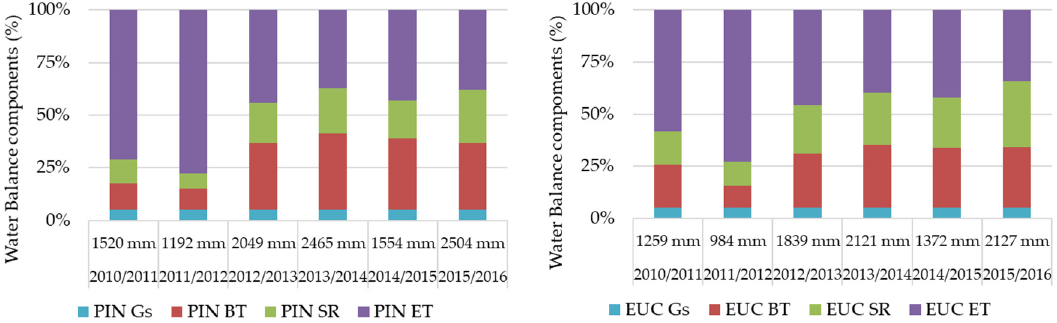
Figure 2. Components of the water balance in both Lourizela (PIN, left side ) and Serra de Cima (EUC, right side ) catchments, as a fraction of the total annual rainfall. Gs, groundwater seepage; BT, base flow; SR, surface runoff; ET, evapotranspiration.